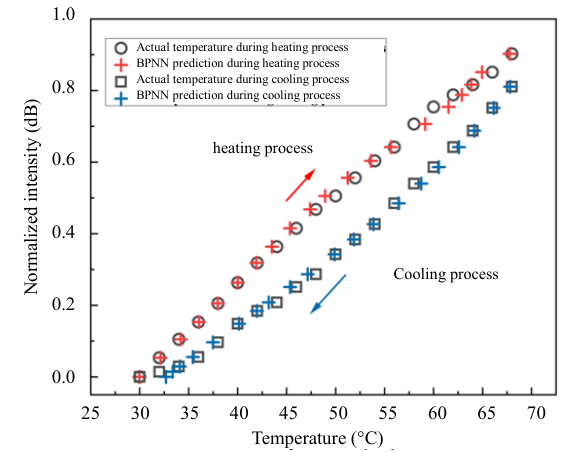
Fig. 11 Prediction skill of BPNN for temperature forecasting in increasing and decreasing sensing processes. The actual data pairs (black cubics/circles) are the same as the ones (black circles) in Figs. 5 and 6.